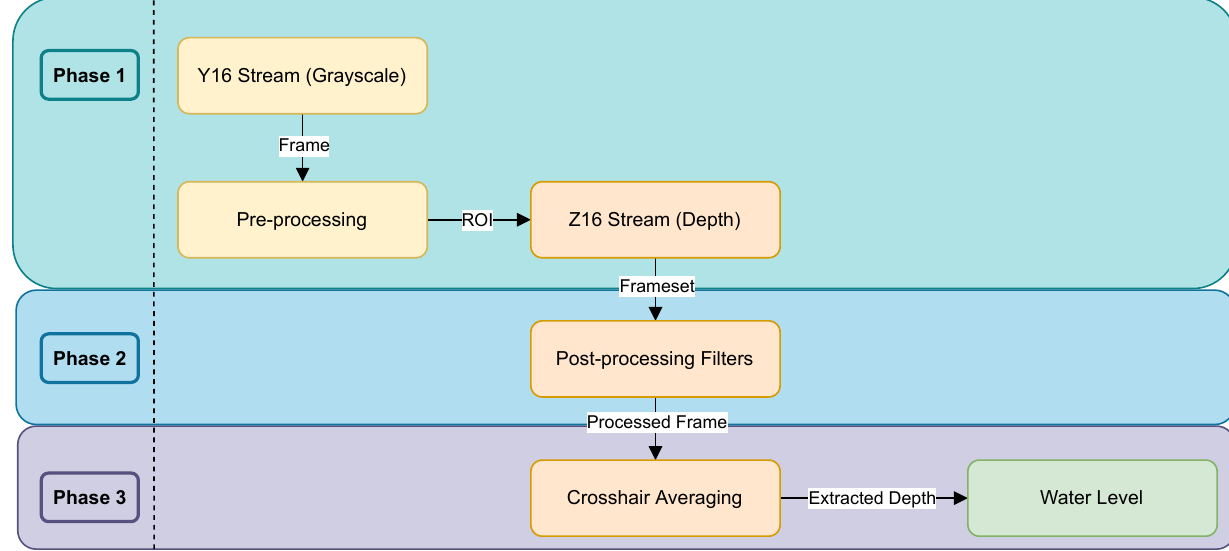
Figure 1. Block diagram of the proposed real-time flood monitoring system.